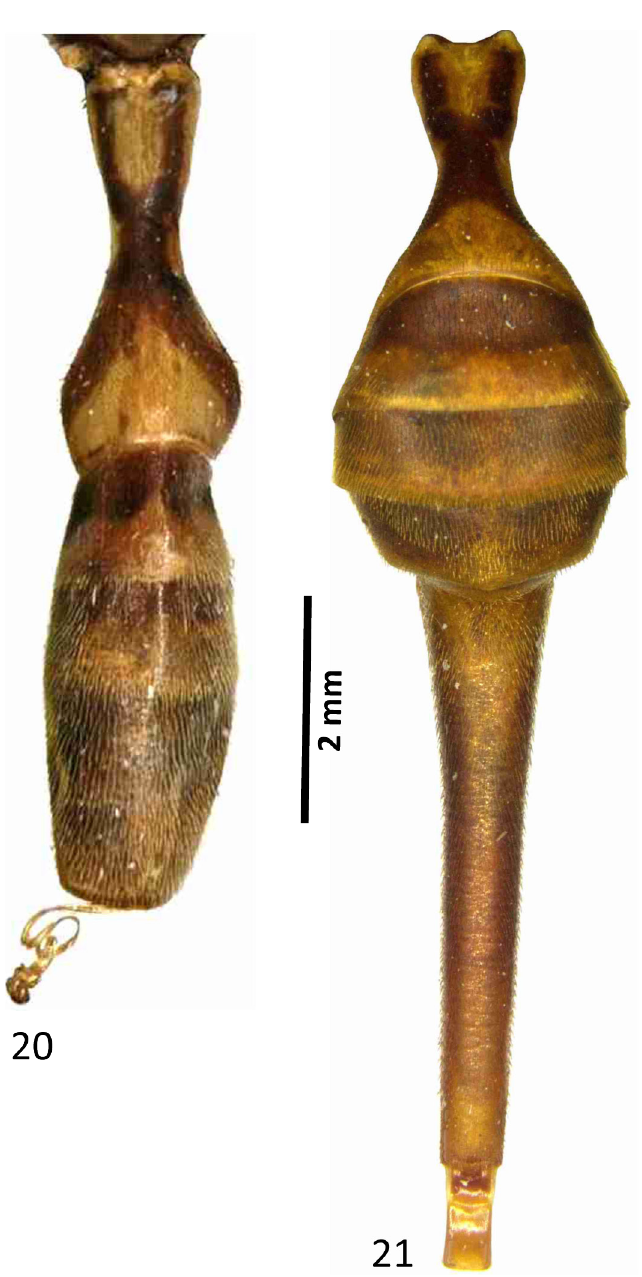
Figs 20–21. Ichneumonopsis burmensis Hardy, 1973, abdomen, dorsal view. 20 . ♂. 21 .